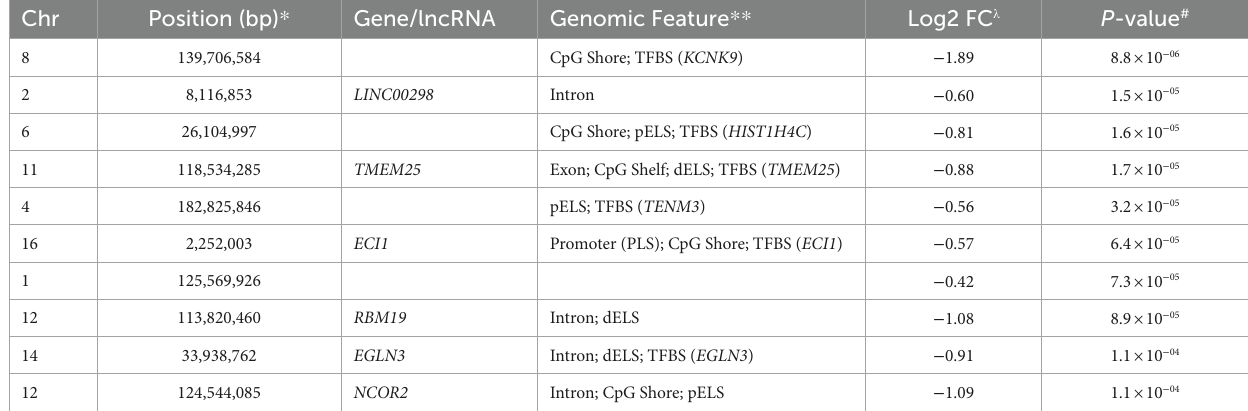
TABLE 1 Top-10 paired t -test results between iPSC and NSC cell lines for log2 (CPM) 5hmC.